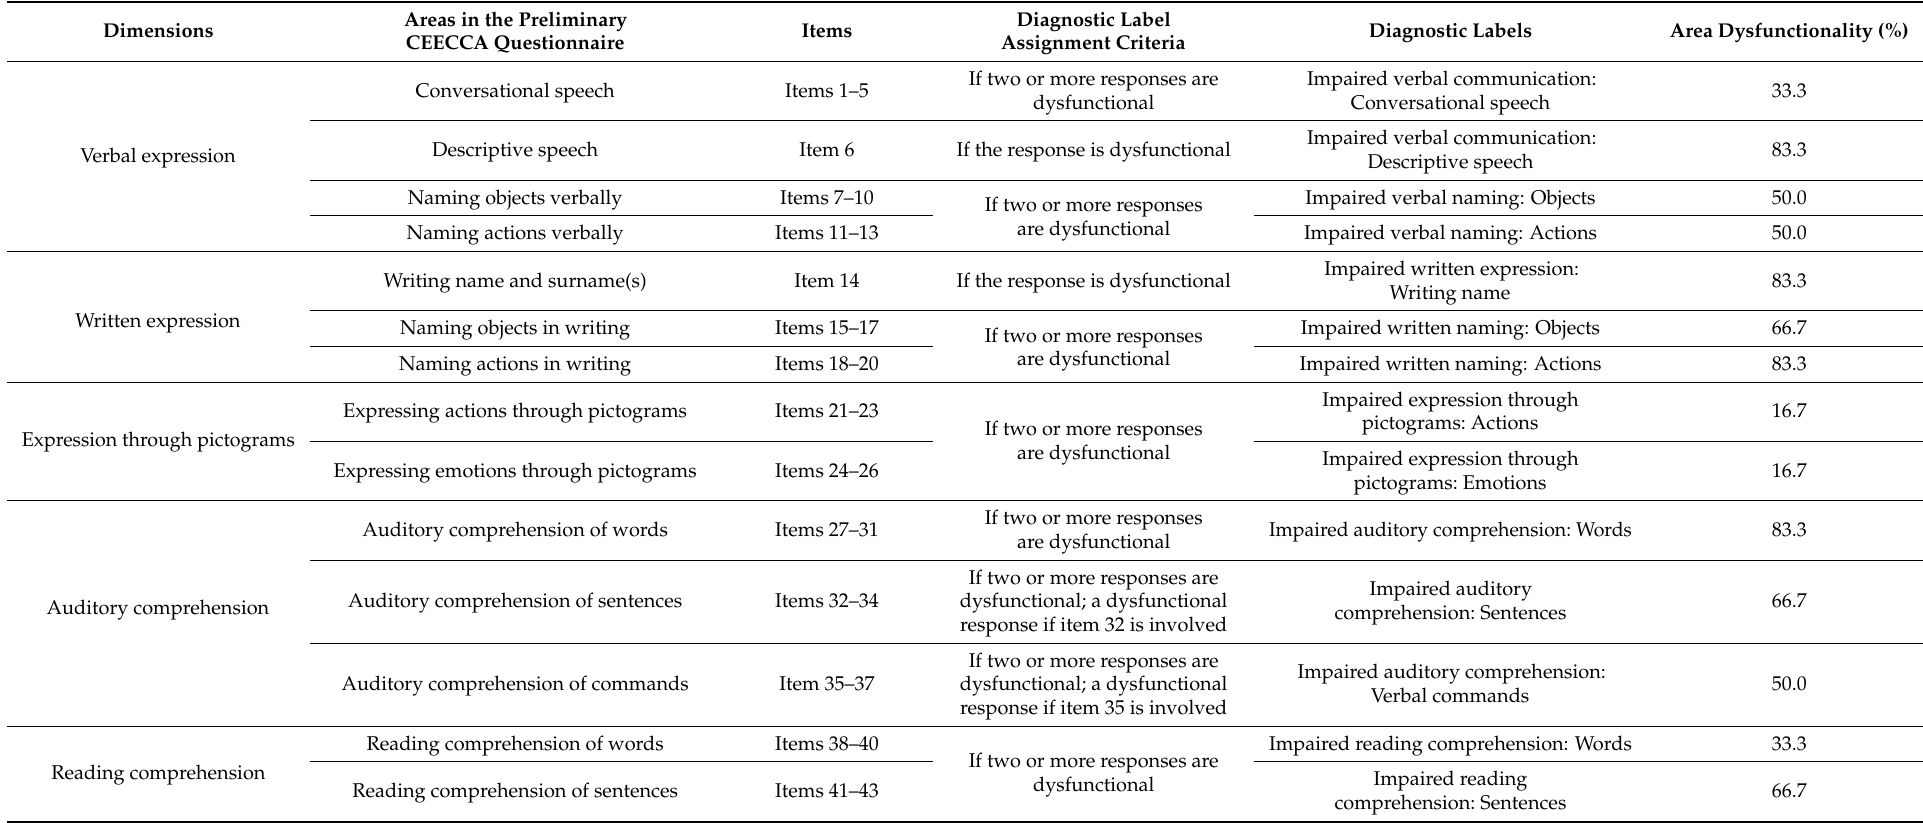
Table 4. Dimensions, areas, and items in the final CEEECA questionnaire. Diagnostic labels and criteria for assigning them. Dysfunctionality percentages after the second phase of the pilot